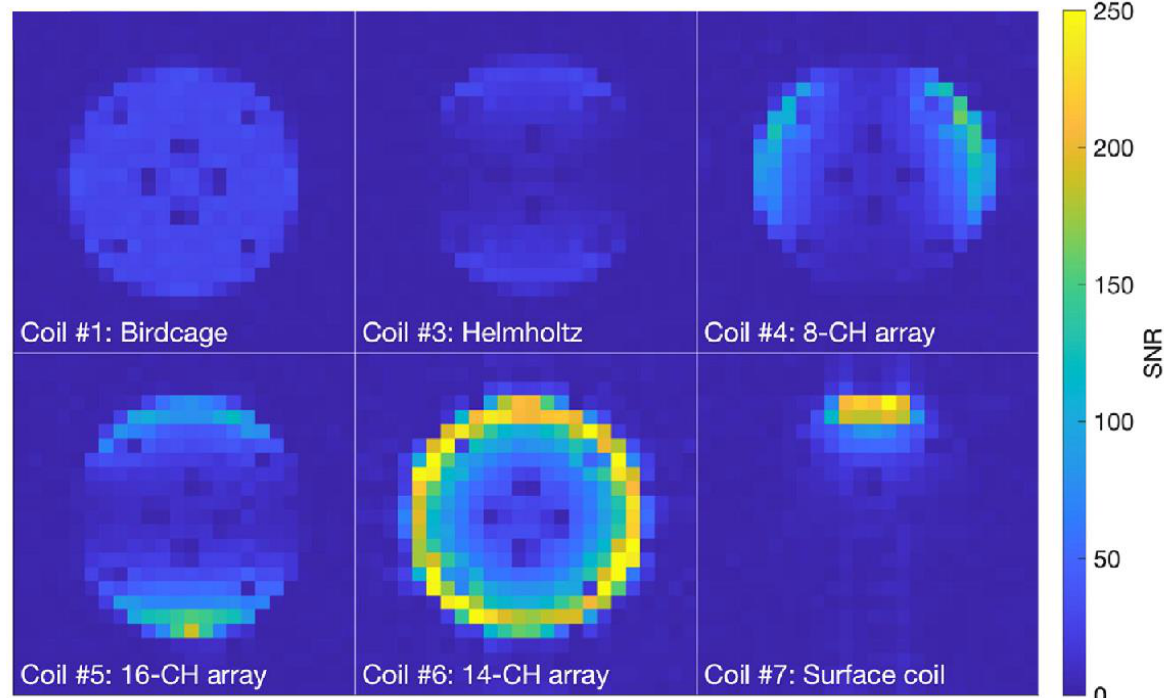
Figure 2. Signal-to-noise ratio (SNR) images obtained with different geometry coils. Reprinted from the Journal of Magnetic Resonance 2020 [7].